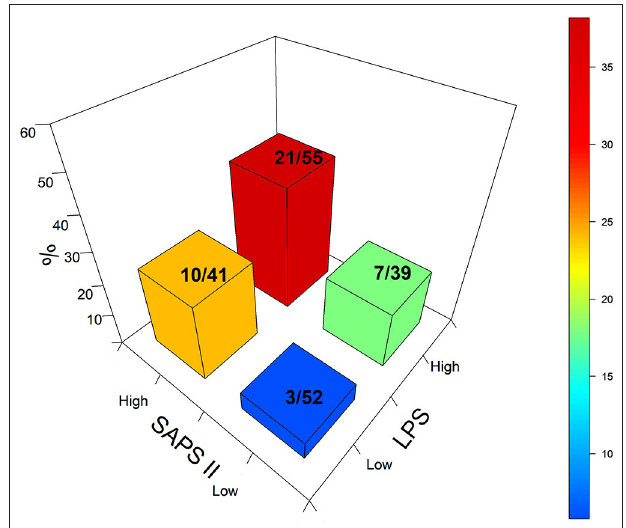
FIGURE 2 | Tri-dimensional representation of death rate based on high and low SAPS II scores 24h after admission and the baseline LPS level. The numbers correspond to the absolute deaths over the total number for each category. Blue: Low SAPS II, low LPS: 5.7% of deaths. Green: High LPS, low SAPS II: 17.9% of deaths. Orange: Low LPS, high SAPS II: 24% of deaths. Red: high LPS; high SAPS II: 38.1% of